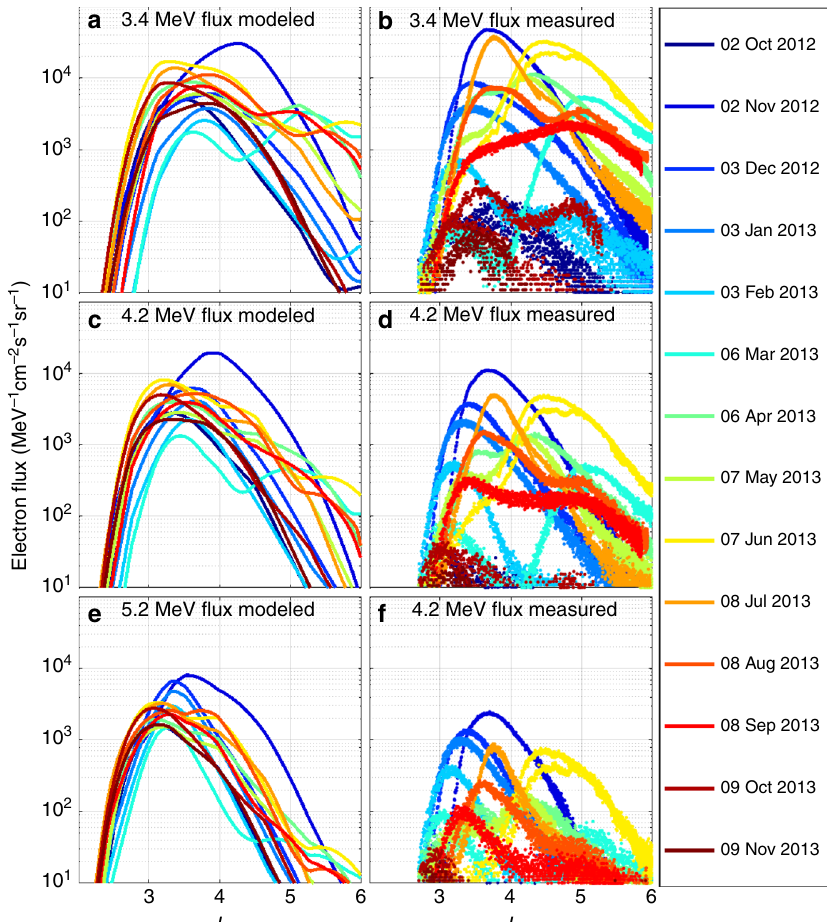
Fig. 2 Observed and simulated ultra-relativistic electron fl ux radial pro fi les at time intervals of 31 days from 2 October 2012 to 9 November 2013. Each color-coded line represents a different pro fi le of the differential electron fl ux at fi xed energies of 3.4 MeV ( a , b ), 4.2 MeV ( c , d ), and 5.2 MeV ( e , f ). The panels on the left show the simulated electron fl ux pro fi les at 12 UT on each different day derived using the D LL [Ozeke] 4 diffusion coef fi cients. The panels on the right show the electron fl ux measured by Van Allen Probe A during each day from 0400 UT to 1600